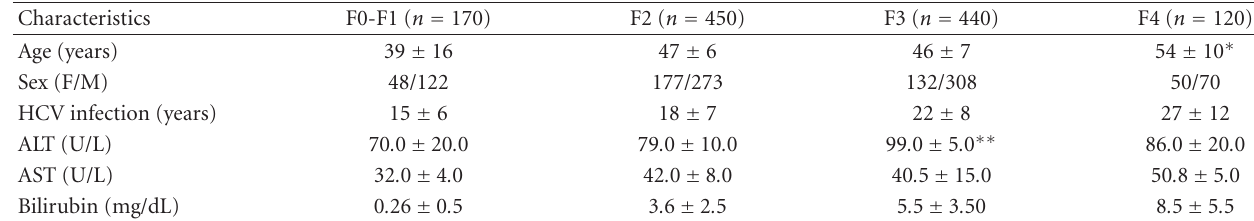
Table 2: Baseline characteristics: HCV-infected